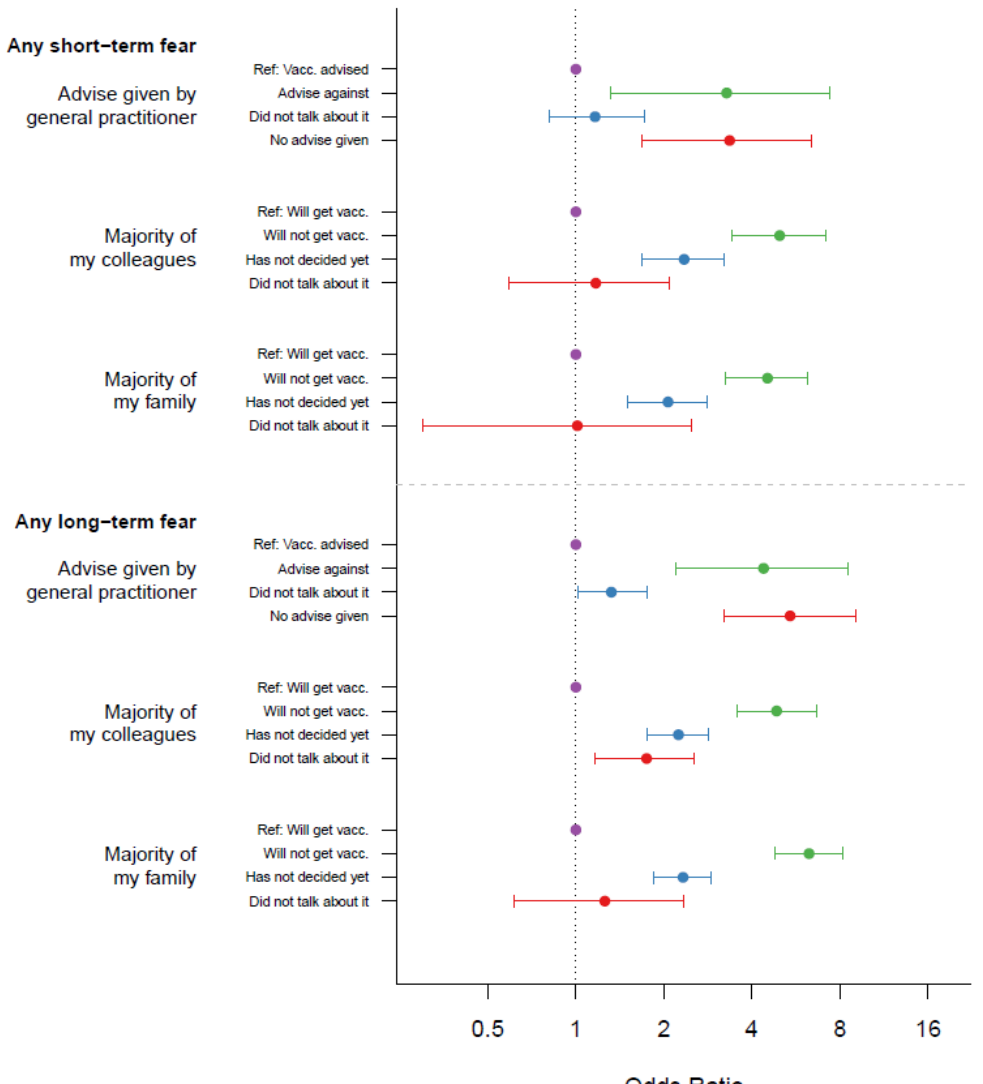
Figure 10. Attitudes towards the COVID-19 vaccination in the personal environment and Odds ratios for side effects (short-term: vaccination reactions excluded).